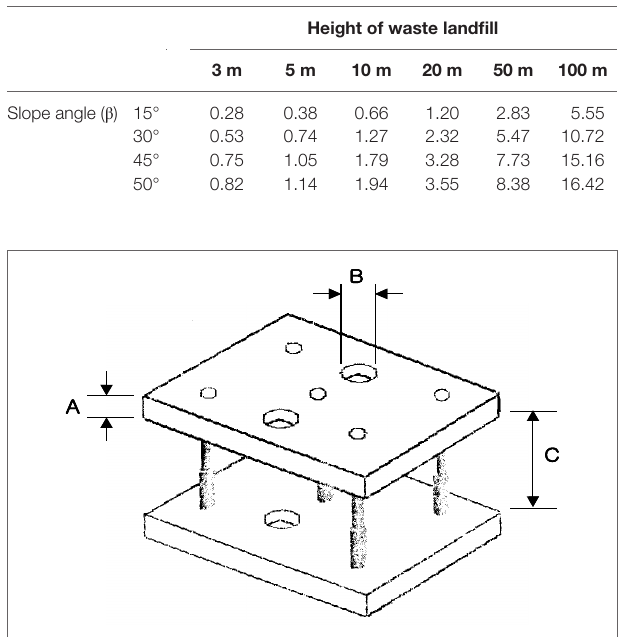
FigUre 5 | configuration of separation box with drainage holes (a) thickness; 5 mm, (B) diameter; 10 mm, (c) height; 30 mm .